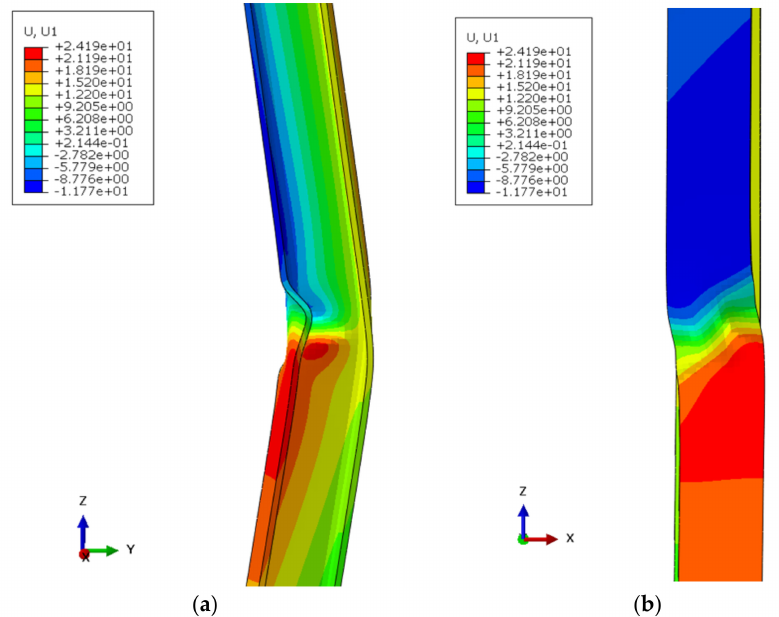
Figure 7. Displacements in X direction (mm) of buckled IPE-200 with initial load applied perpendicularly to the strong inertia axis, mechanical slenderness of 29.3: ( a ) front view; ( b ) lateral